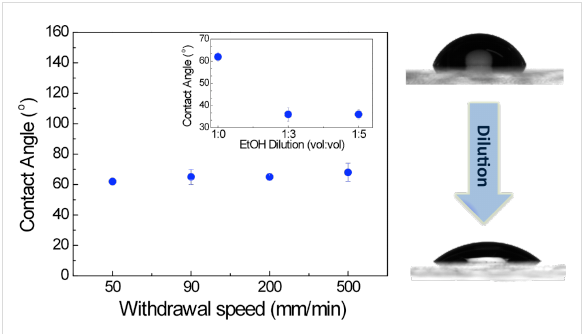
Figure 2: Contact angle measurements of a silica layer deposited by dip coating onto a glass substrate at different withdrawal speeds (left). Contact angle measurements of a silica layer deposited by dip coating at a 50 mm/min withdrawal speed onto a glass substrate as a function of ethanol dilution of the initial sol (right).